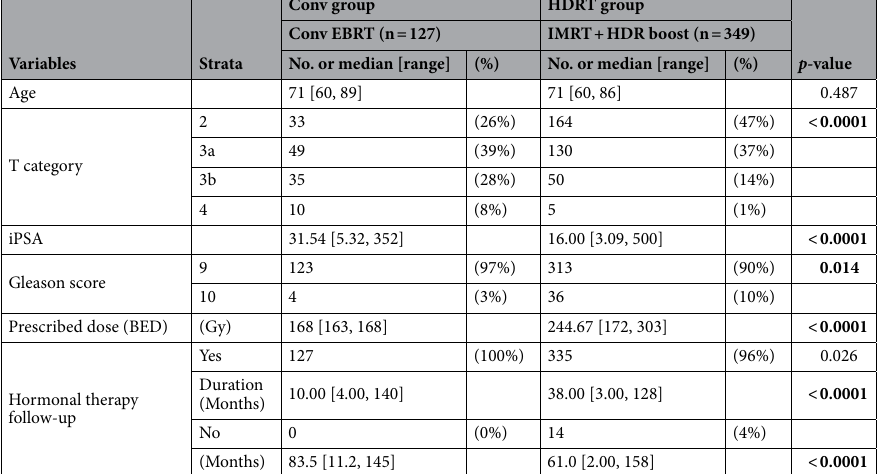
Table 1. Comparison of backgroud patients characteristics between Conv RT and DeRT group. Characteristics and treatment factors of patients. HDR boost high dose rate brachytherapy boost, EBRT external beam radiotherapy. EQD 2 Gy = n × d × (α/β + d)/(α/β + 2) (α/β = 1.5 Gy, n = fraction number, d = single dose). BED = n × d × (1 + d/(α/β)); (α/β = 1.5 Gy, n = fraction number, d = single dose). Bold values